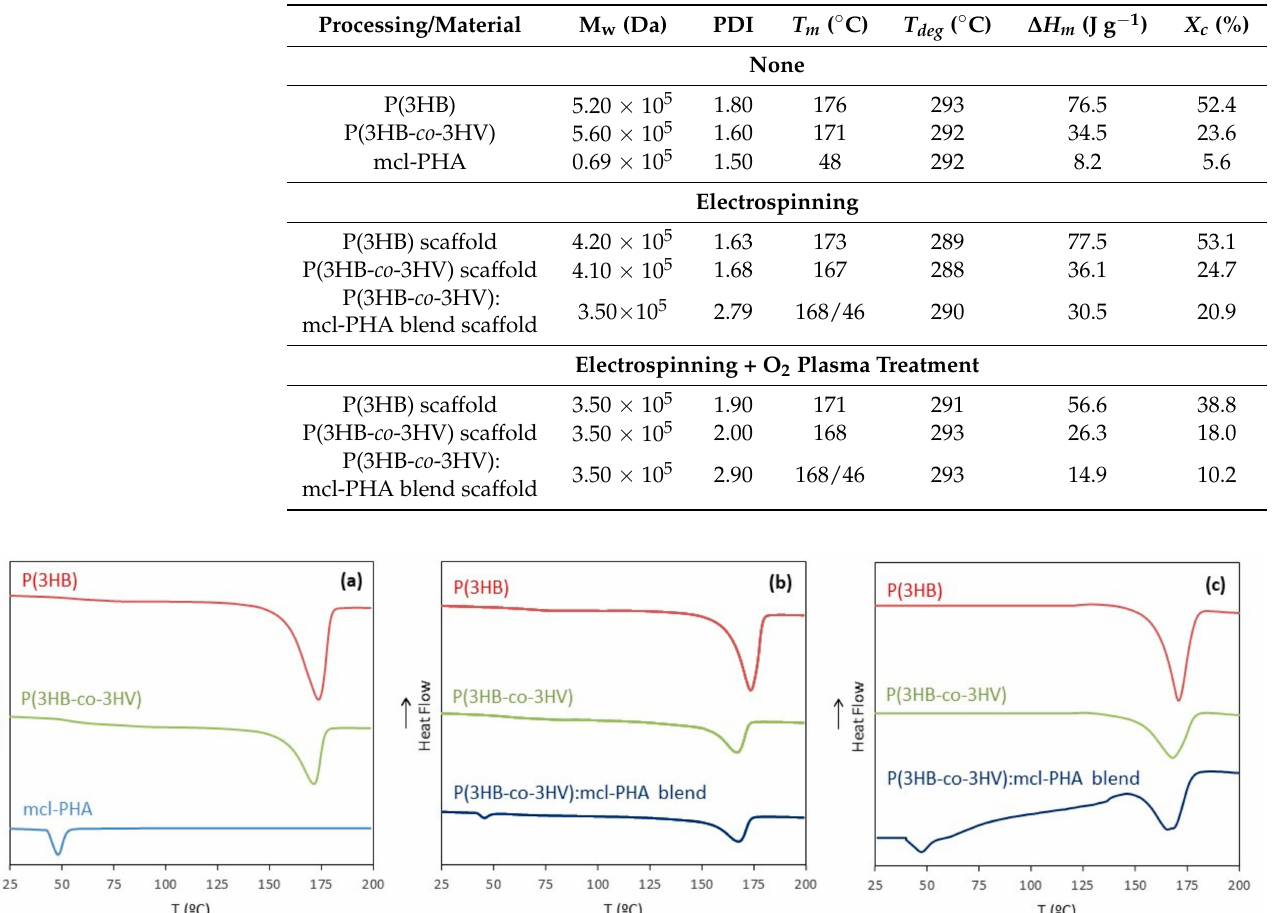
Table 1. Molecular mass distribution and thermal properties of the biopolymers P(3HB), P(3HB-co- 3HV) and the mcl-PHA, as well as those of the scaffolds obtained by electrospinning and after oxygen plasma treatment (M w , molecular weight; PDI, polydispersity index; T m , melting temperature; T deg , degradation temperature; X c , crystallinity fraction; ∆ H m , melting enthalpy).